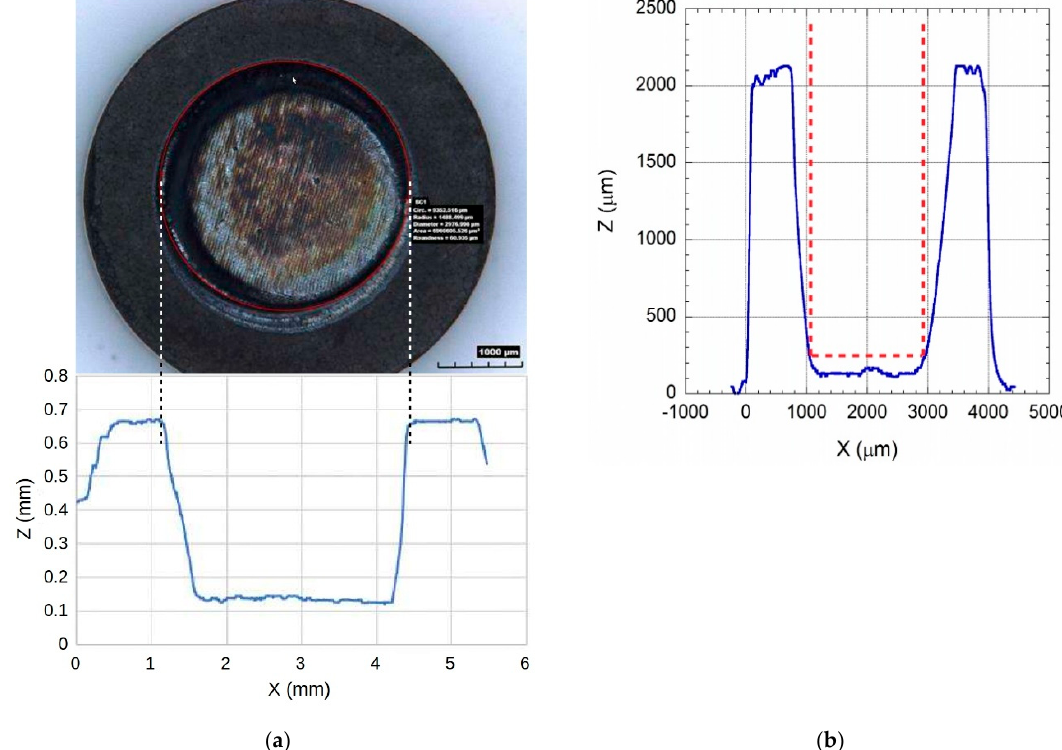
Figure 4. ( a ) An example of laser-treated S-SiC sample (top). Hole diameter is around 3 mm. The structure of the bottom of the hole reveals the cross method adopted during laser treatment. The 2D profile reconstruction obtained by means of digital microscopy analysis is reported on the bottom. ( b ) 2D profile reconstruction for a sample with a membrane with ~ 2 mm diameter and ~ 150 µm thickness. Dotted lines represent glass ferrule-terminated SMF inserted in the engraved S-SiC sample (see Section 2.1).